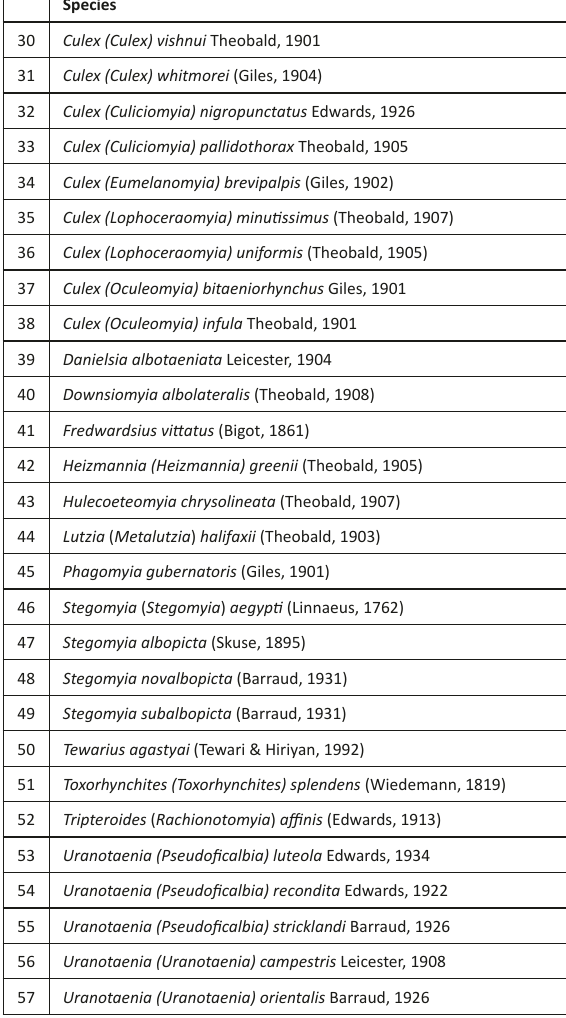
Table 2. List of mosquito species collected from Kanniyakumari and Tirunelveli districts foothills of Western Ghats - 1986. (CRME Mosquito Museum Book, Tewari et al. 2007) Species